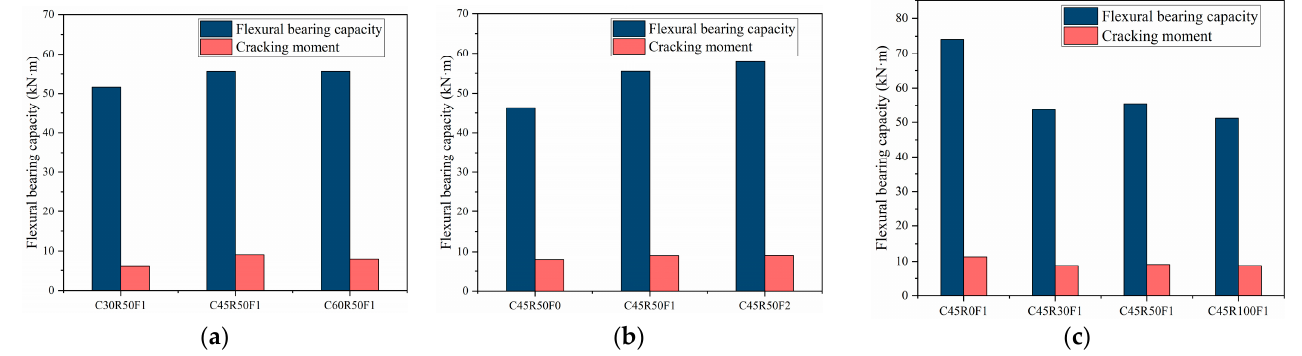
Figure 10. Flexural bearing capacity of SFRAC beams. ( a ) Concrete strength, ( b ) steel fiber volume fraction, ( c ) recycled aggregate replacement ratio.